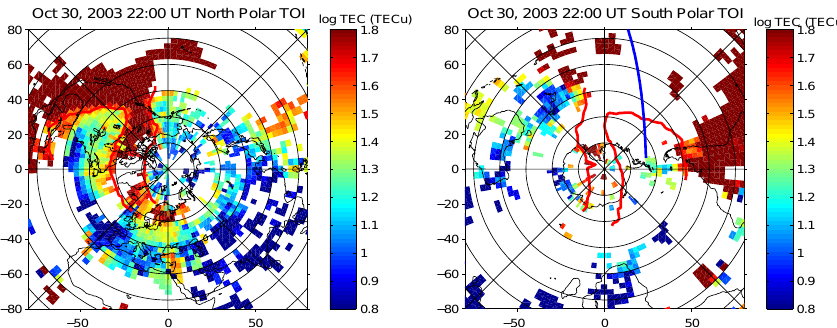
Fig. 5. Left: The data of Fig. 2 are displayed in polar coordinates with noon at the top. The strong SED plume extended across the north polar cap forming a pronounced polar tongue of ionization (TOI). The 35TECu iso-contour (red) outlines the SED and TOI. This contour has been mapped to its conjugate locations in the Southern Hemisphere (right) where sparse GPS TEC data from Antarctica indicate the formation of a conjugate TOI. The orbital track of the Jason satellite (data shown in Fig. 2) is indicated by the blue trace. Latitude circles are shown at 15 deg